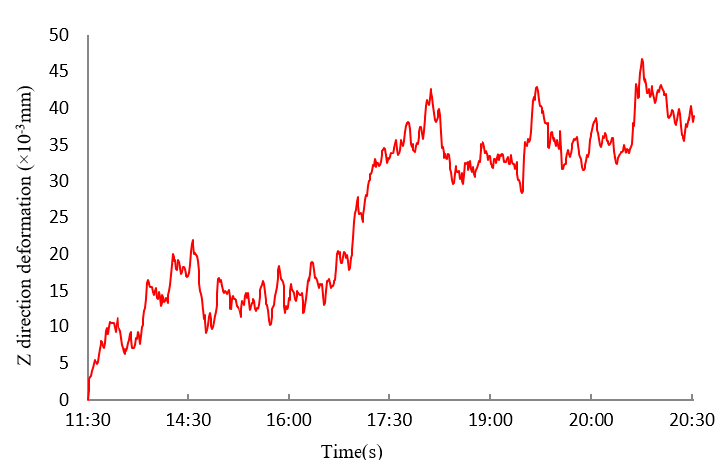
Figure 9. Thermal error in the z-direction of the spindle.